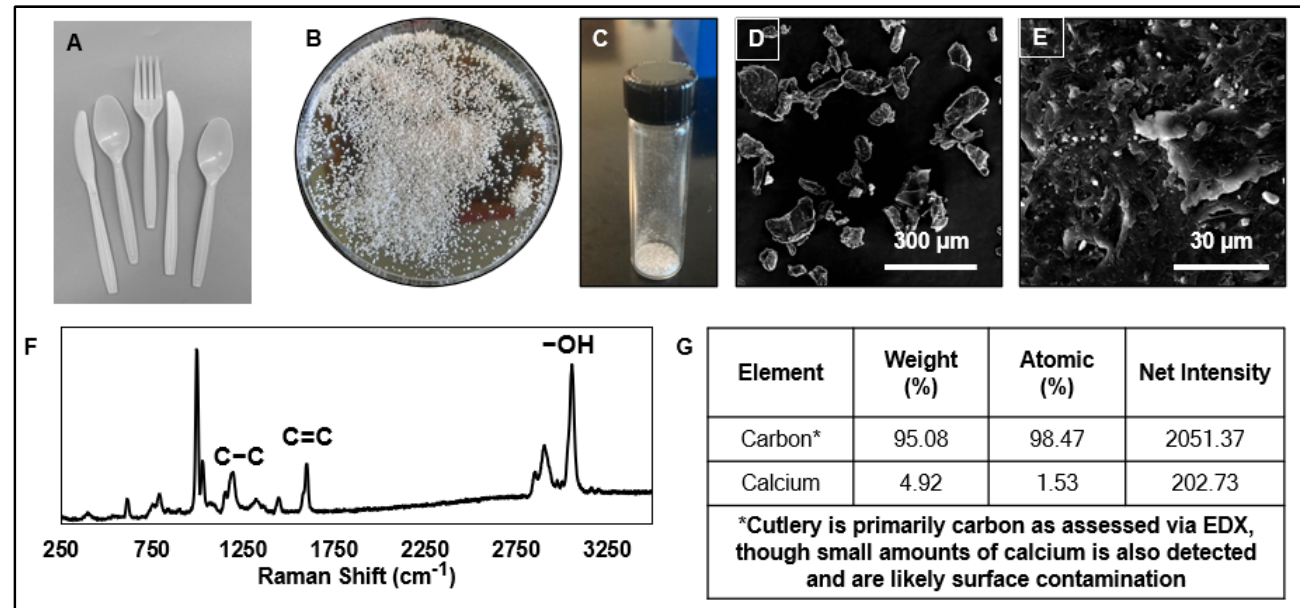
Figure 1. Physicochemical characterization of the microplastic particles used in this study. ( A ) Photograph of the white plastic cutlery prior to grinding. ( B ) Photograph of the plastic after grinding. ( C ) Photograph of size-separated microplastic particles. The mean (±SD) size of the first particle size population is 93 ± 23 µm. The mean (±SD) size of the second particle size population is 27 ± 17 µm. ( D , E ) Scanning electron micrographs of the microplastic particle size population with scale bars of 300 µm and 30 µm, respectively. ( F ) Raman spectroscopy of particles indicating polystyrene polymeric structure. ( G ) Elemental composition, as measured by energy-dispersive X-ray (EDX) spec- troscopy, indicates the presence of carbon and calcium. Both particle size populations exhibited the same Raman and EDX spectral patterns.